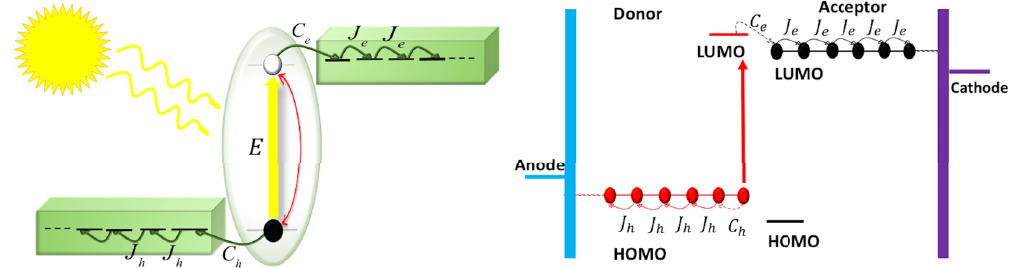
Fig. 1. The two-level model in the permanent (left panel) and transitory (right panel) regime of illumination. (Left panel) A molecular photocell with one HOMO and one LUMO orbitals attached to the electrodes. The red line represents the electron- hole interaction and recombination inside the molecule and the hopping integrals of electron and hole are denoted by C and J . E is the energy of absorbed photon. (Right panel) Schematic representation of a donor-acceptor system. Charge evacuation leads are considered as semi-infinite chains. Here, J e and J h are the coupling energies between two adjacent sites in the electron and hole chains, respectively. Also, C e and C h represent the first coupling energies between the interface states and charge evacuation leads.